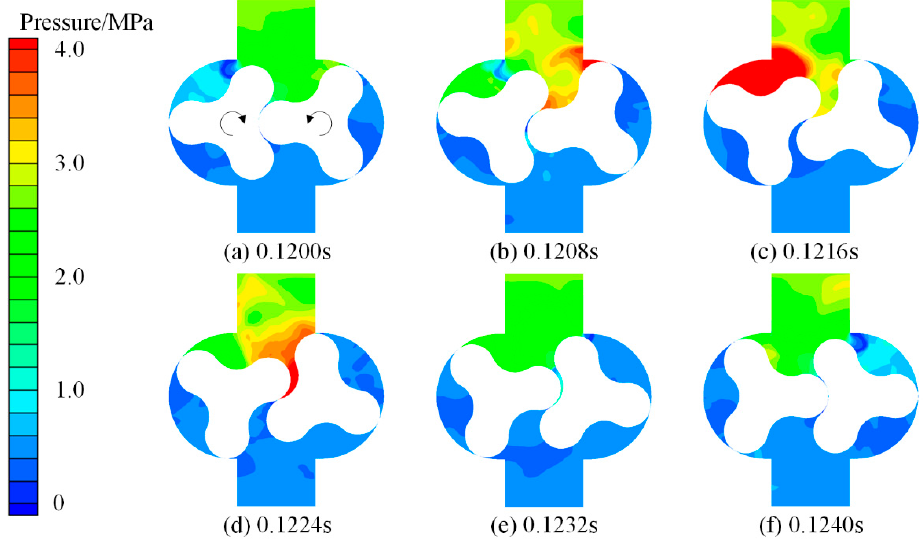
Figure 21. Pressure contours of the Roots pump when the pressure ratio is 6. Flow time: ( a ) 0.1200 s; ( b ) 0.1208 s; ( c ) 0.1216 s; ( d ) 0.1224 s; ( e ) 0.1232 s; ( f ) 0.1240 s.